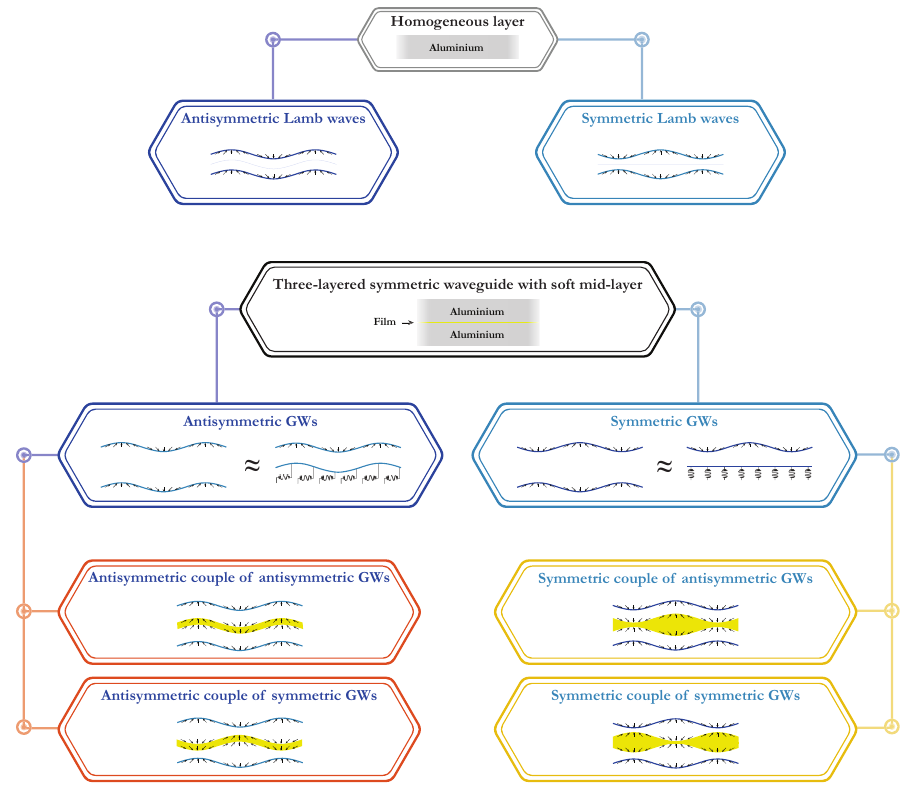
Figure 6. Classification of GWs propagating in homogeneous elastic waveguide and symmetric three-layered waveguide with thin soft mid-layer.